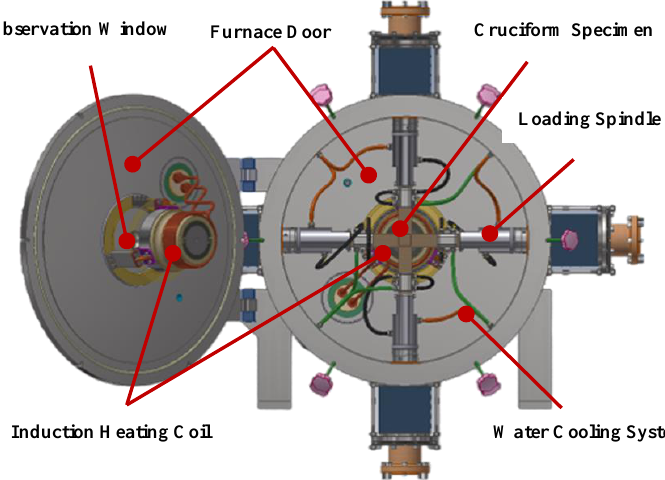
Figure 8. Internal structure of the high-temperature furnace.